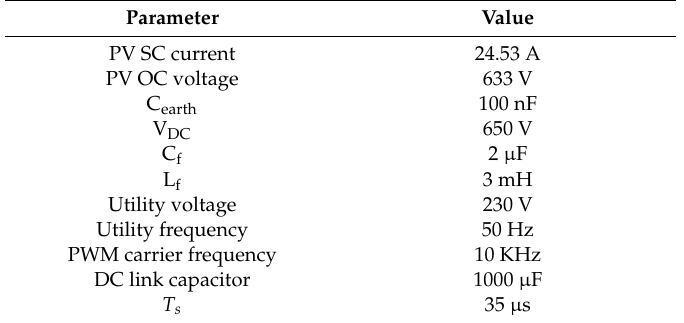
Table 1. System parameters.